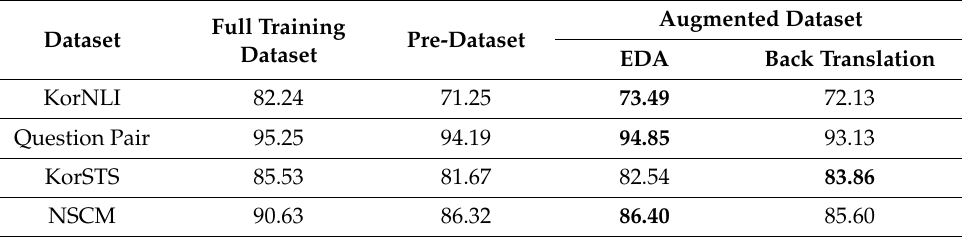
Table 4. Performance on downstream tasks of pre-trained KoELECTRA-Base-v3: NLI, natural language inference (accuracy); QUAD, question duplication (F1); STS, semantic textual similarity (Spearman); NSCM, sentiment classification